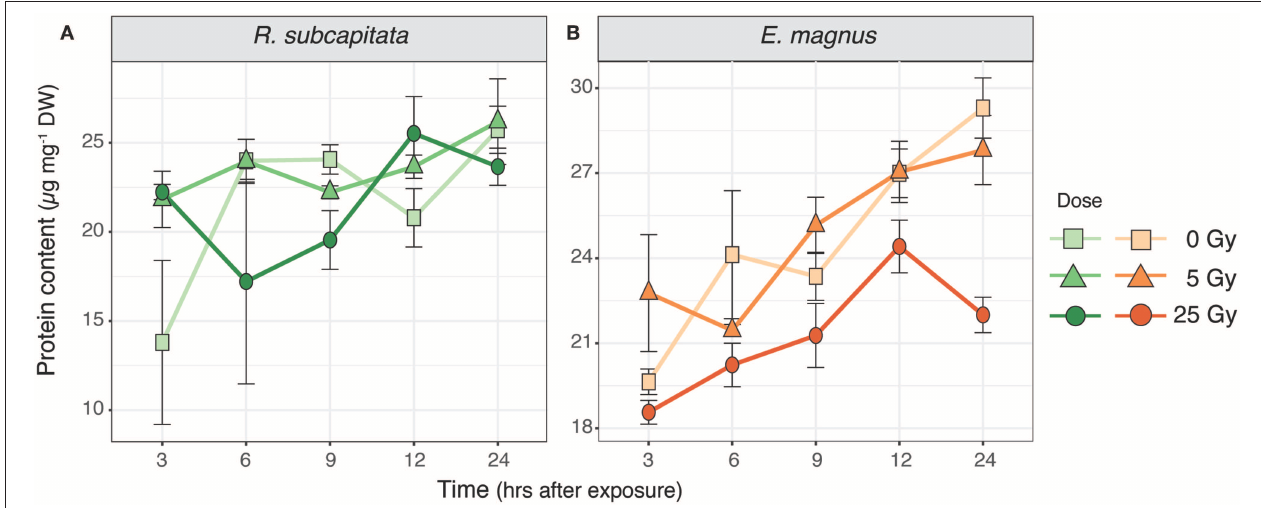
FIGURE 5 | Protein content in (A) R. subcapitata and (B) E. magnus over time per dose (mean ± SE; n = 3).